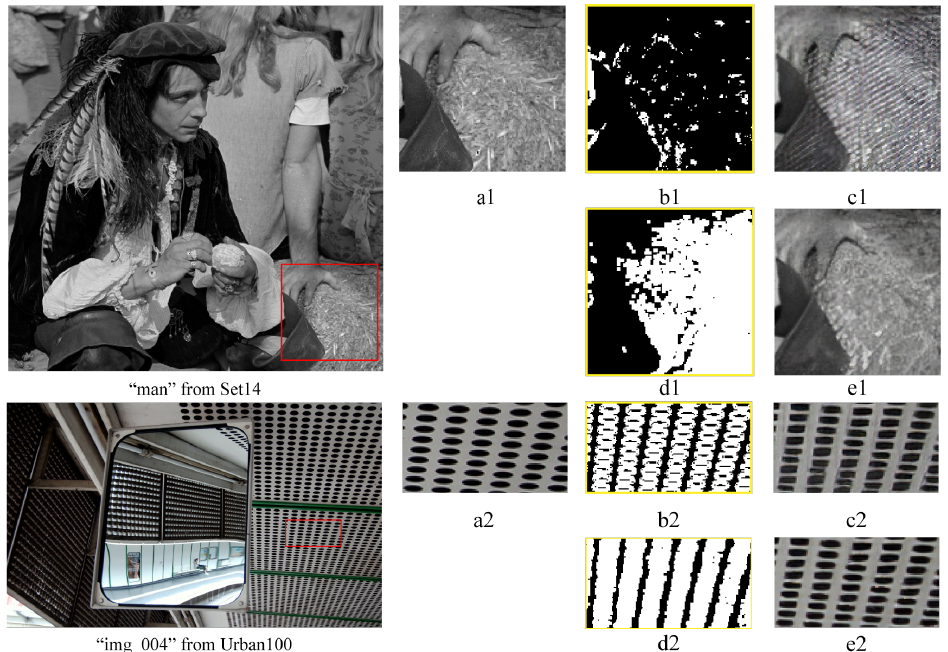
Figure 3. Comparison the IG-DC and EU-DC. ( a1 , a2 ) man’s original and img_004’s original of ROI, ( b1 , b2 ) man’s Hard map and img_004’s Hard map defined by the IG-DC, ( c1 , c2 ) man’s result and img_004’s result restored by the IG-DC, ( d1 , d2 ) man’s Hard map and img_004’s Hard map defined by the EU-DC, and ( e1 , e2 ) man’s result and img_004’s result restored by the